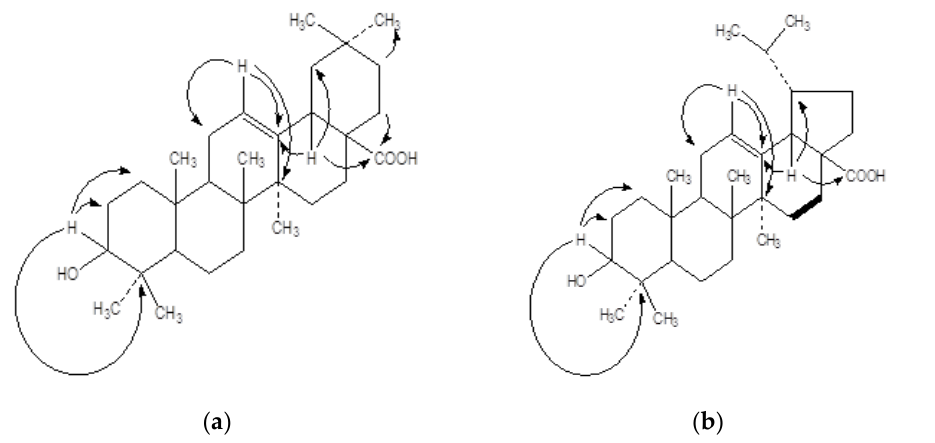
Figure 2. HMBC interaction in ( a ) SA-1 ( b ) SA-4. Table 2. 1 HNMR and 13 CNMR data of compound